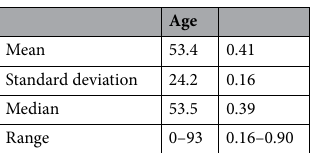
Table 1. Descriptive statistics for age and R PF . n = 132. R PF : protein-folding intensity.